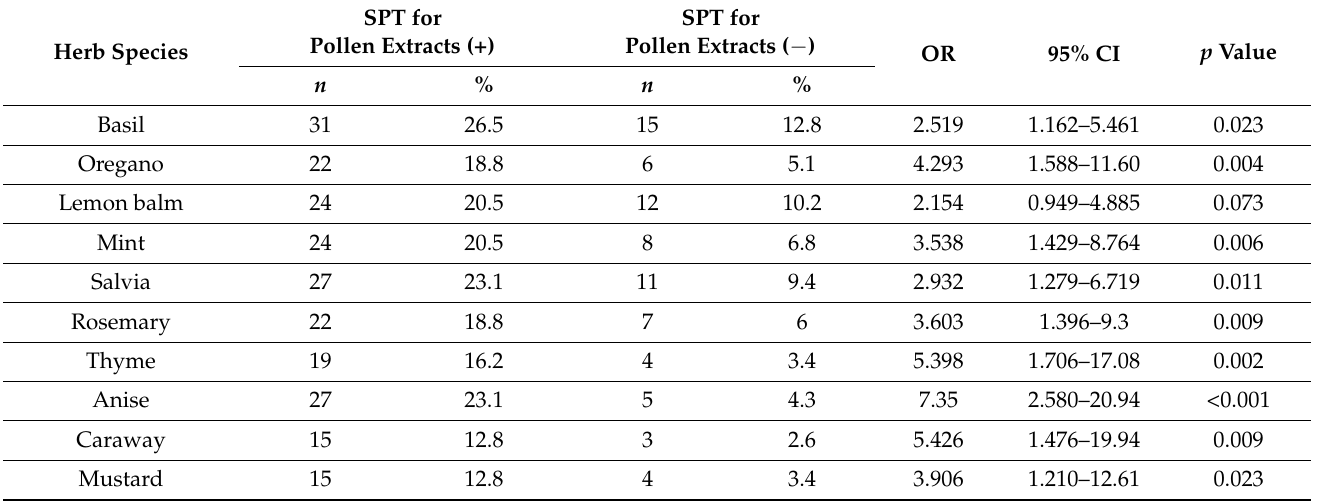
Figure 3. Incidence of positive SPT reaction to fresh extracts of basil, oregano, lemon balm, mint, salvia, rosemary, thyme anise, caraway and mustard in pediatric group ( n = 63). Table 1. Incidence and odds ratio (OR) of positive SPT ( Φ ≥ 3 mm) for particular herbs in relation to positive (+) or negative ( − ) SPT for pollen extracts in